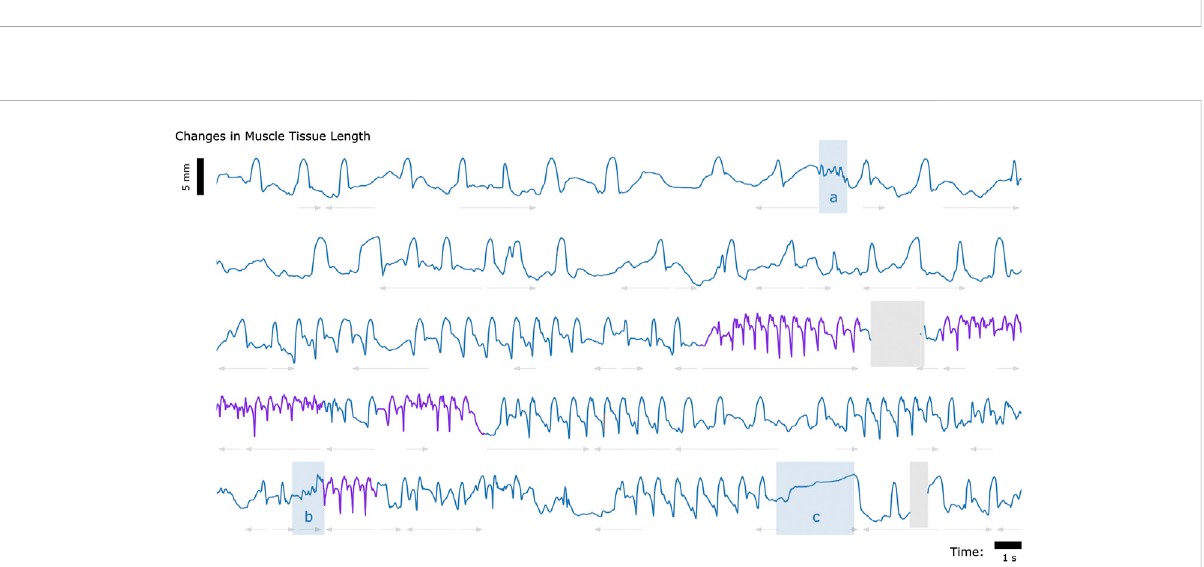
FIGURE 5 Muscle Tissue Length During Free Roaming Movement. Magnetomicrometry data was continuously collected for 150 s during free roaming activity. Muscle tissue length is plotted in blue during standing and walking and plotted in purple during running. Blue highlighted regions indicate muscle tissue length during (a) feather ruf fl ing, (b) jumping, and (c) balancing on one leg. Gray arrows indicate when the turkey was turning left (left arrows) or turning right (right arrows). Gaps due to wireless transmission packet drops are shown in gray, as described in Figure